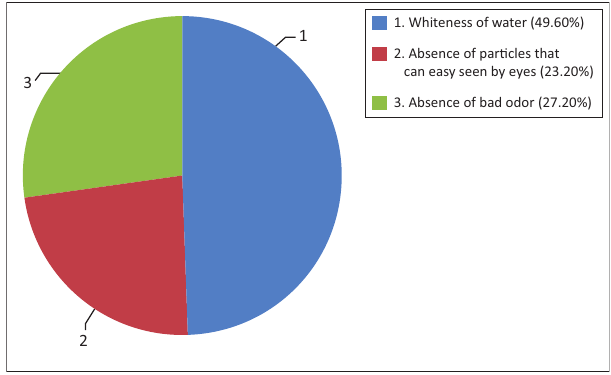
FIGURE 5: Perception on the water quality. TABLE 3: Laboratory results of water test. S.No. Parameter